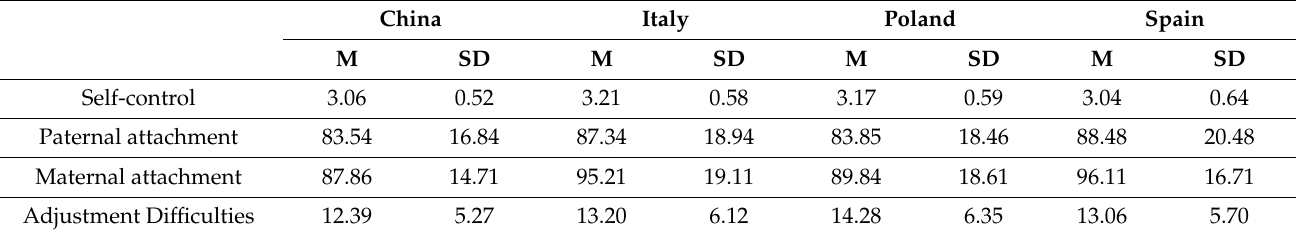
Table 1. Mean (M) and standard deviation (SD) of all variables among the four countries.